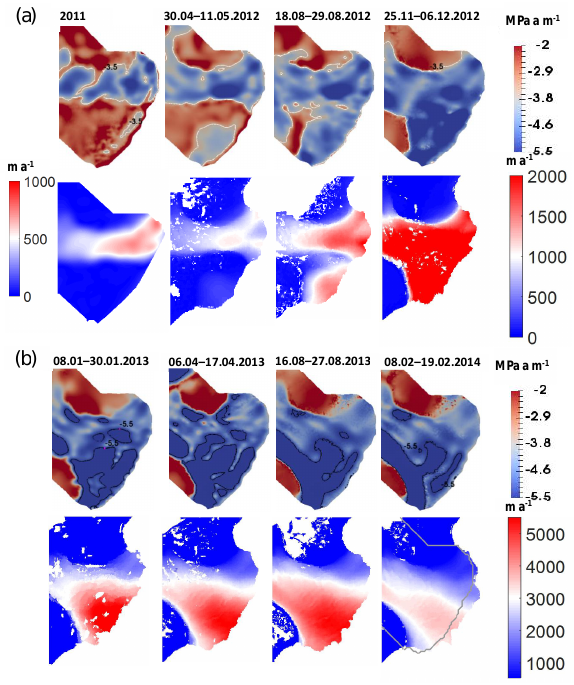
Figure 4. The evolution of the basal friction coefficient ( C) , with the corresponding observed speeds plotted below, shown for the model domain of HiDEM: (a) log 10 (C) , overlain with white con- tour lines showing log 10 (C) = − 3 . 5 (low friction), from the time before the peak of the surge; (b) log 10 (C) , overlain with black contour lines showing log 10 (C) = − 5 . 5 (almost vanishing friction), from the time period at and after the peak of the surge. The speed in 2011 was acquired from ERS-2 SAR imagery (colour bar on the left). The rest of the speed snapshots were from TSX SAR (colour bar on the right). The grey solid line outlines the Basin 3 boundary.